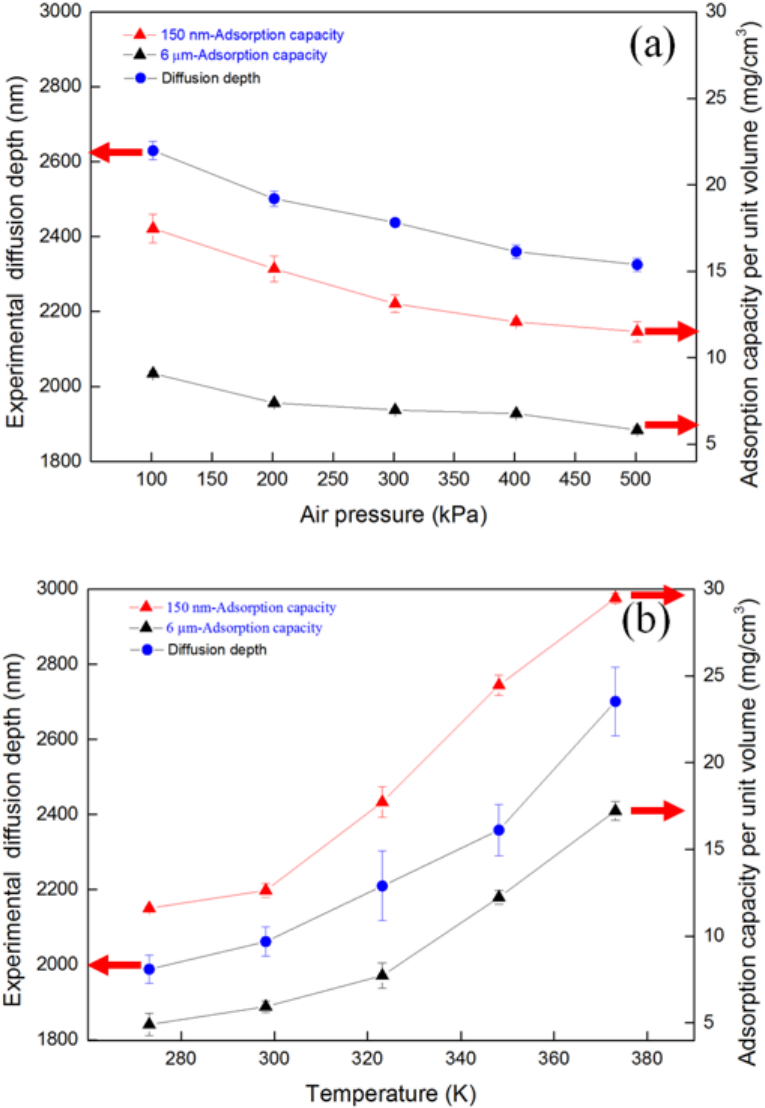
Figure 6. Calculated diffusion depths from measured data under different ( a ) air pressures and ( b ) air temperatures.